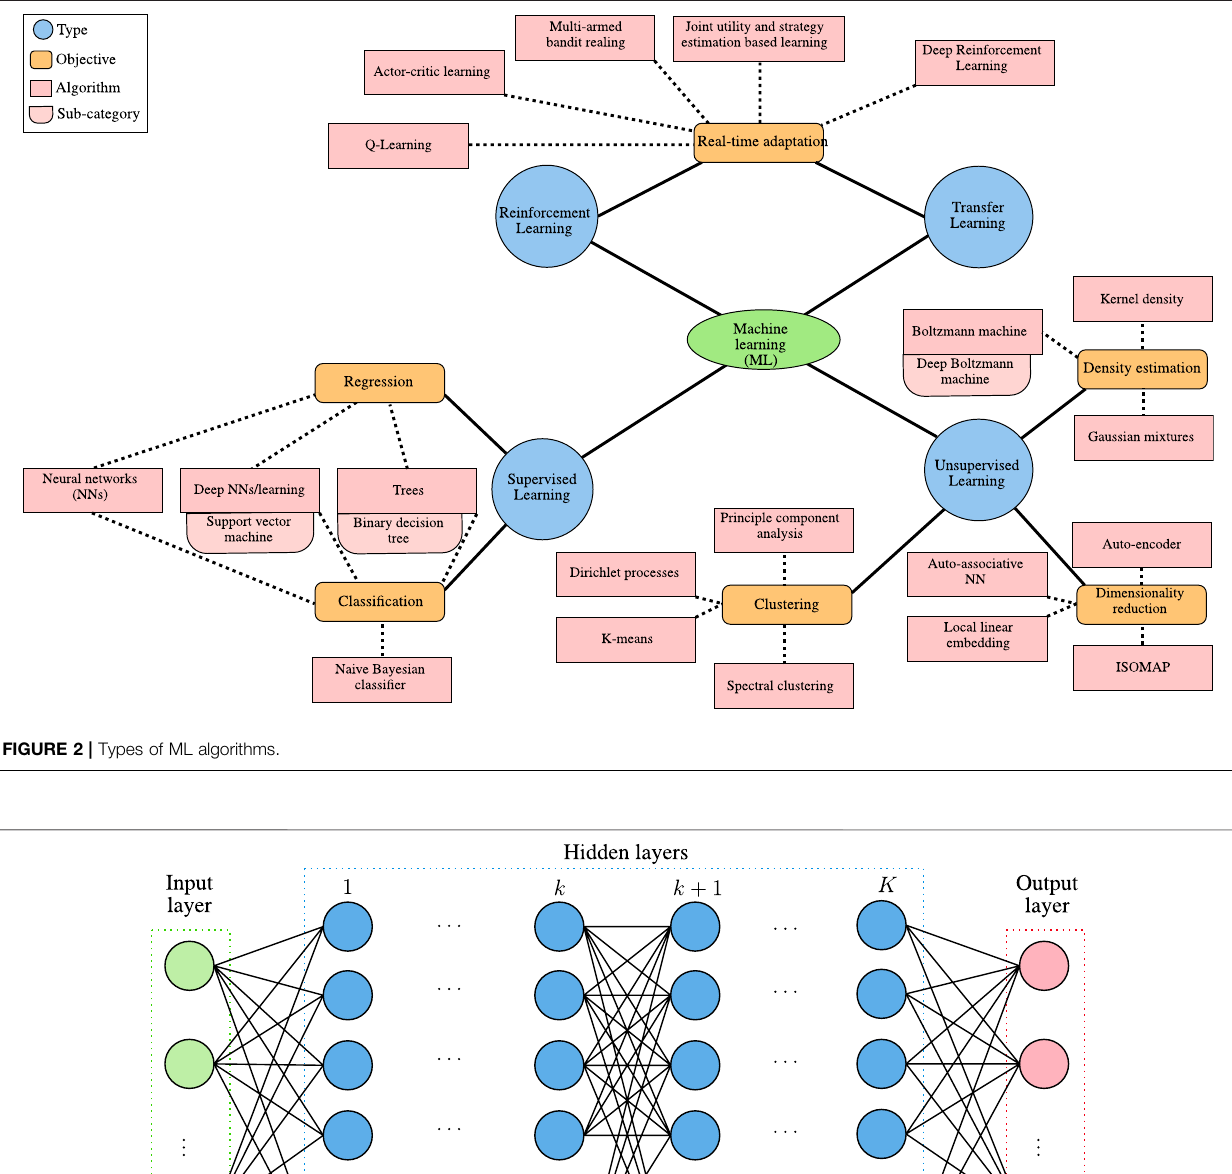
FIGURE 3 | General NN